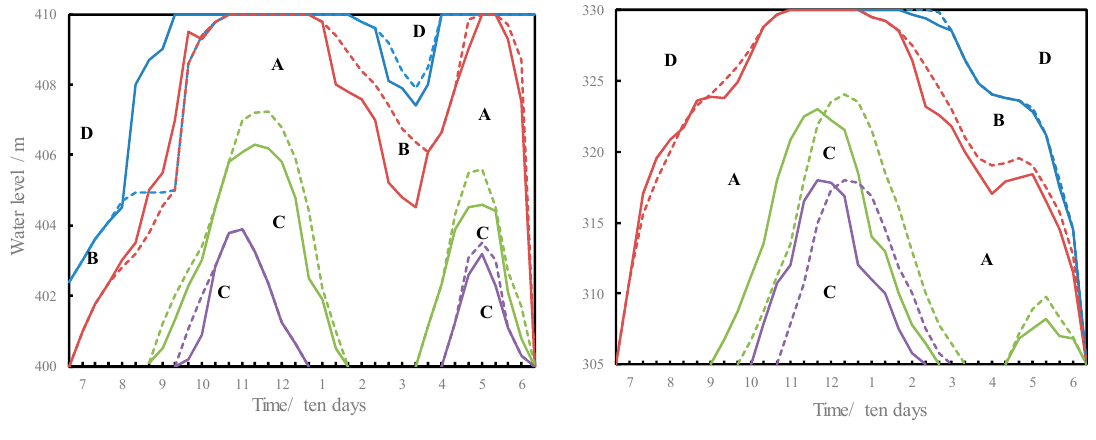
Chart 1: Modified regular single reservoir operation charts 400402404406408410